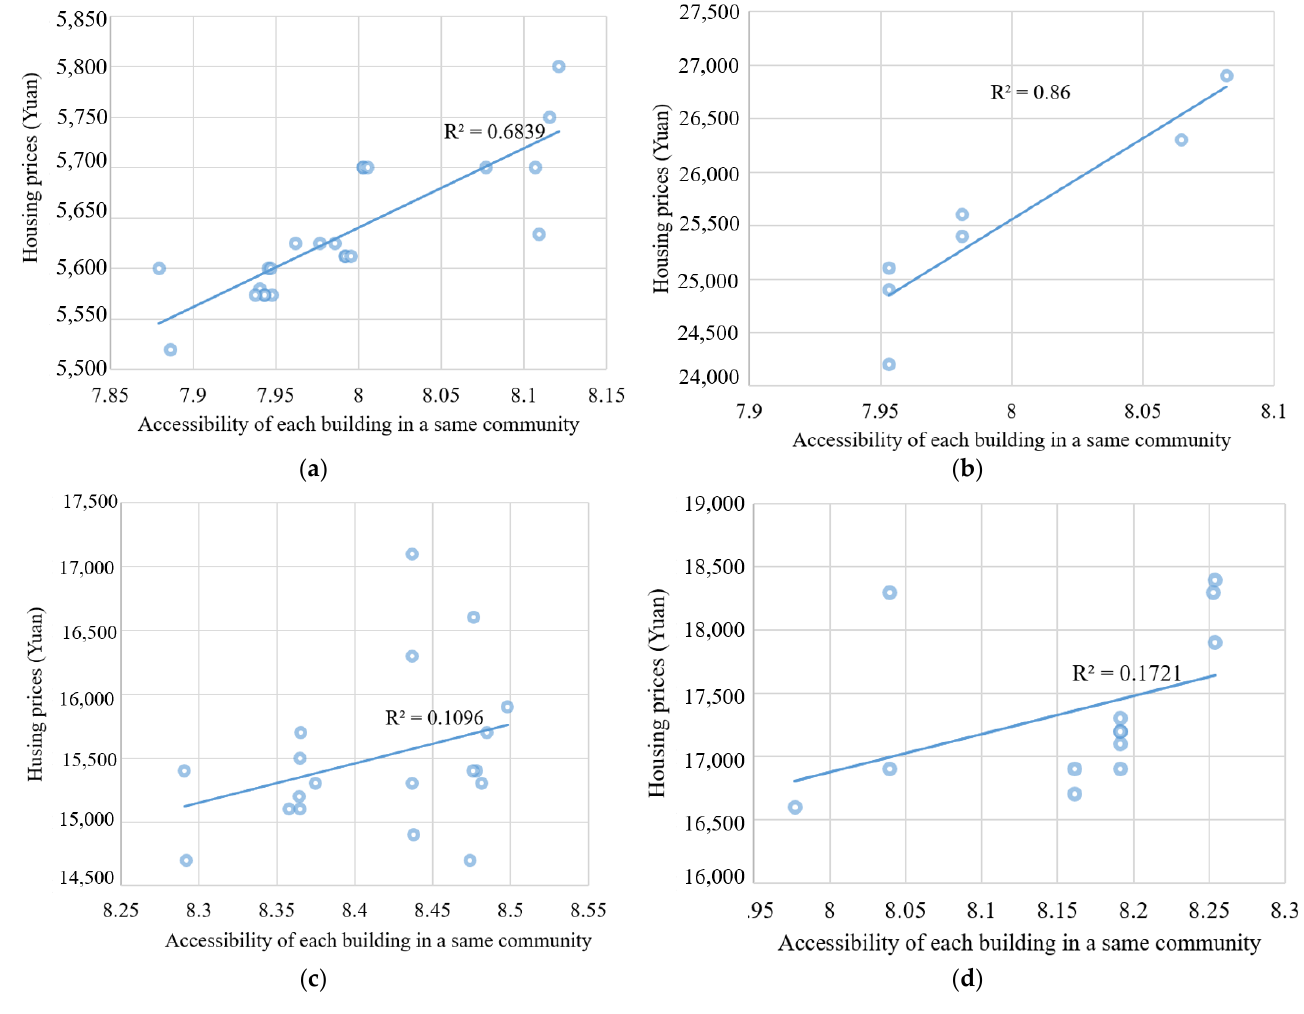
Figure 11. The correlation between accessibility and housing price of buildings in the experimental area; ( a , b ) respectively show communities in area with lower overall accessibility; ( c , d ) respectively indicate communities in area with higher overall accessibility.